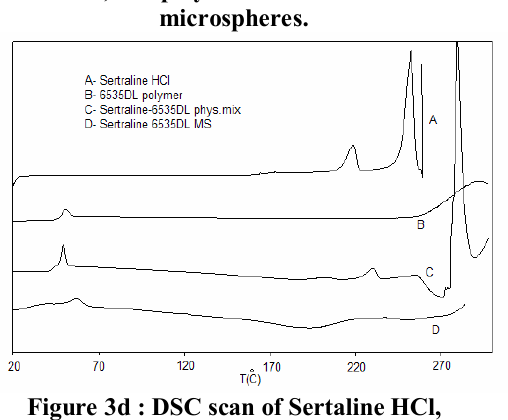
Figure 3d : DSC scan of Sertaline HCl, Sertaline HCl-6535DL polymer physical mixture, 6535DL polymer and Sertaline HCl 6535DL microspheres.